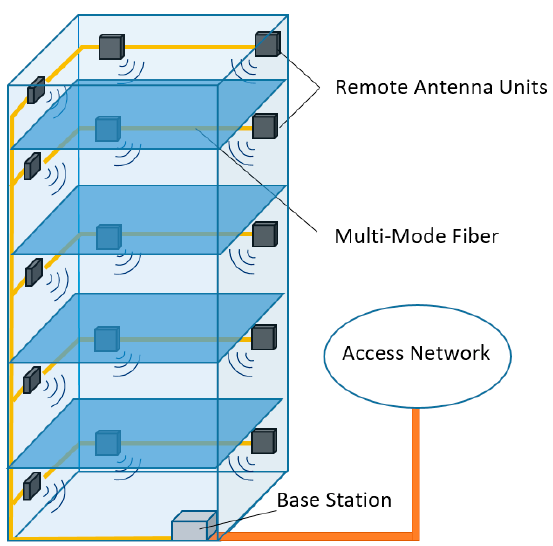
Figure 1. Scheme of a distributed antenna system (DAS) fed by multi-mode fiber (MMF) for indoor networks.